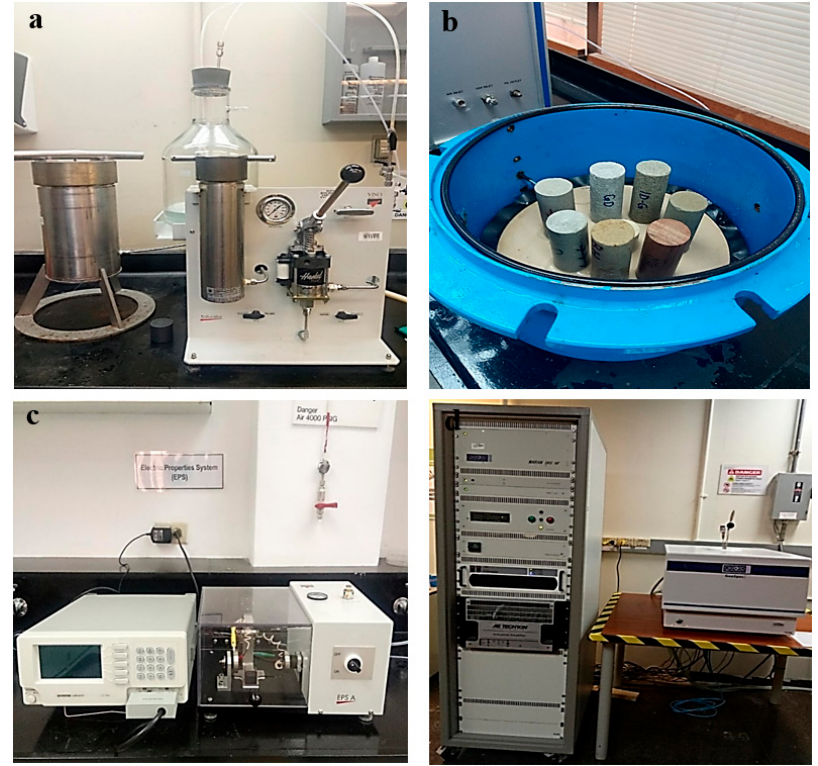
Figure 12. ( a ) Vacuum saturator; ( b ) porous plate capillary pressure cell; ( c ) electrical resistance meter; ( d ) NMR Geospec 2.1 rock